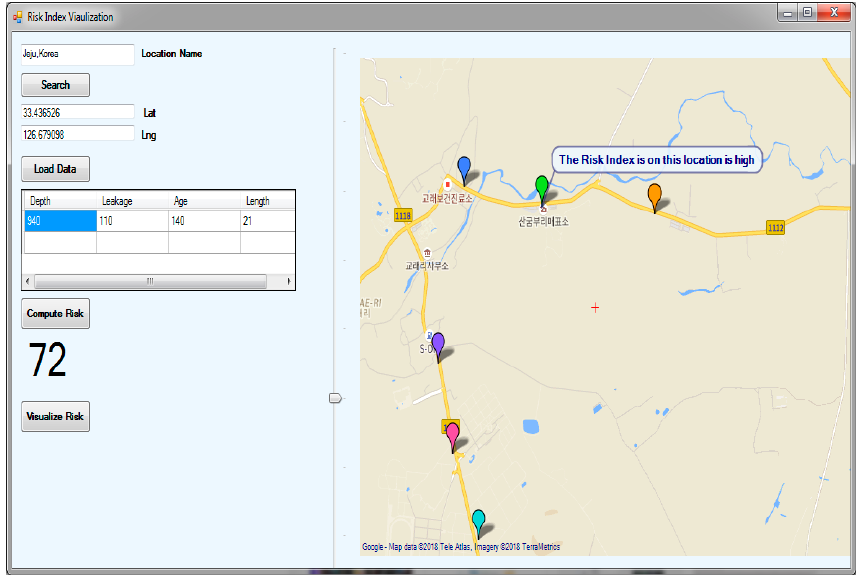
Figure 18. Water supply pipeline risk index visualization.